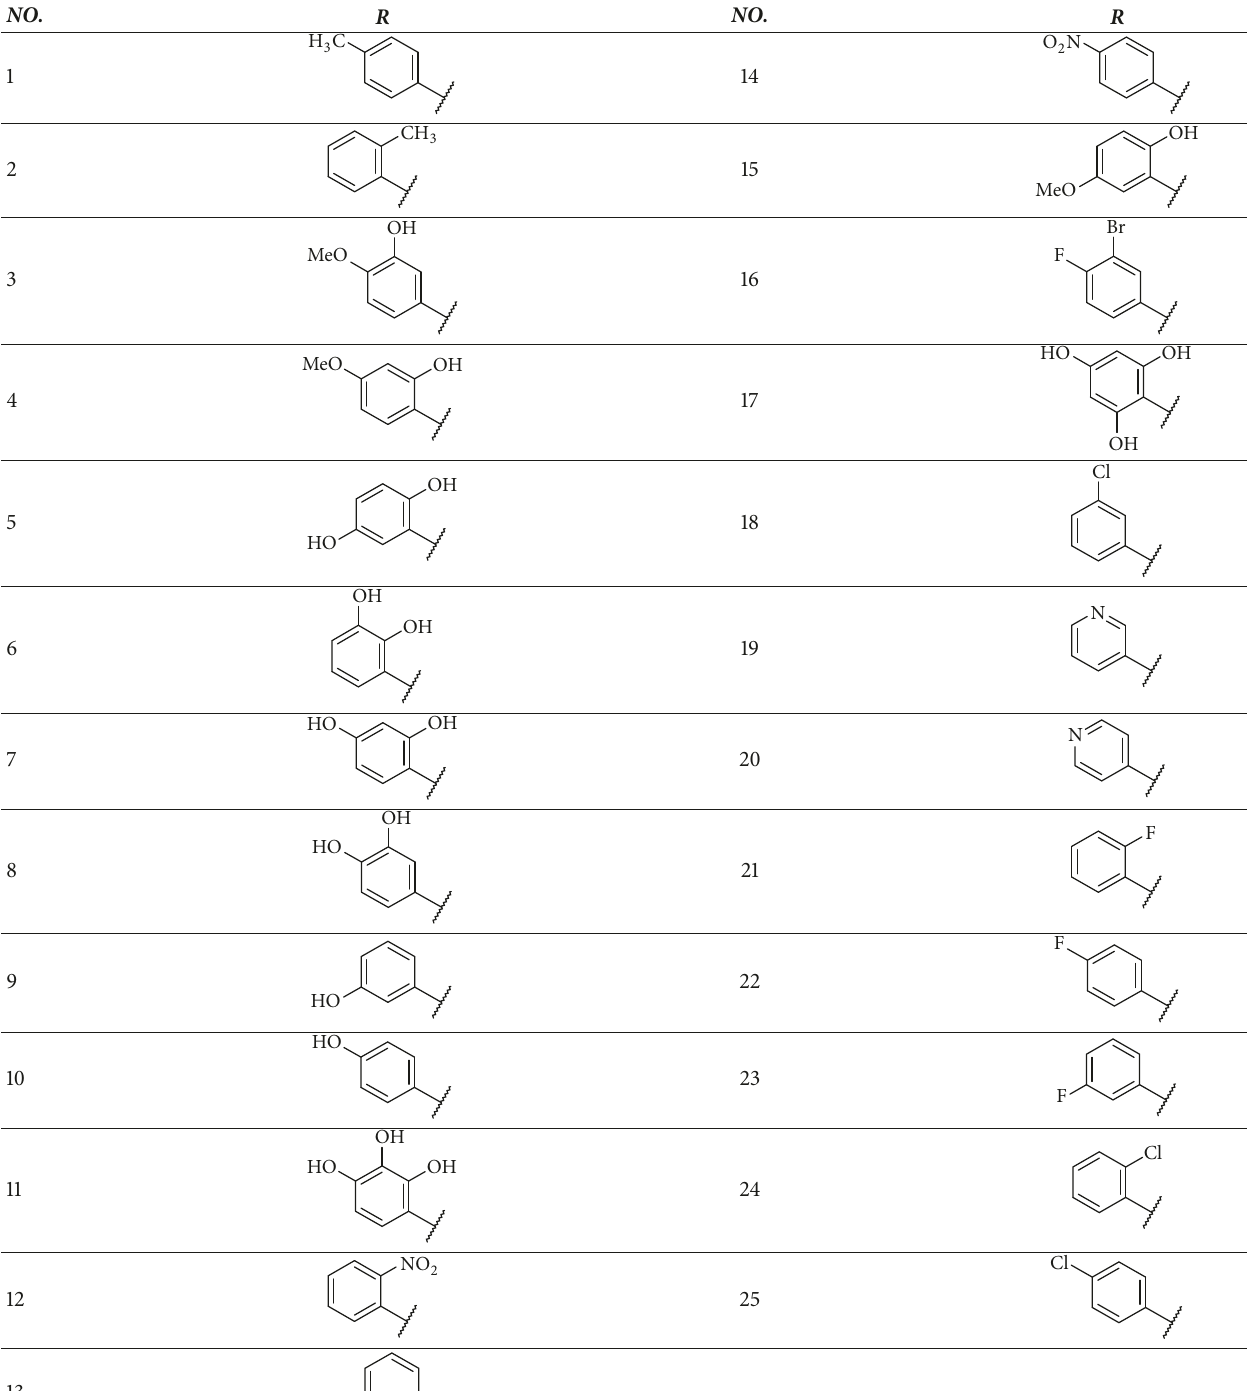
Table 1: Thiazole based carbohydrazide analogs ( 1-25